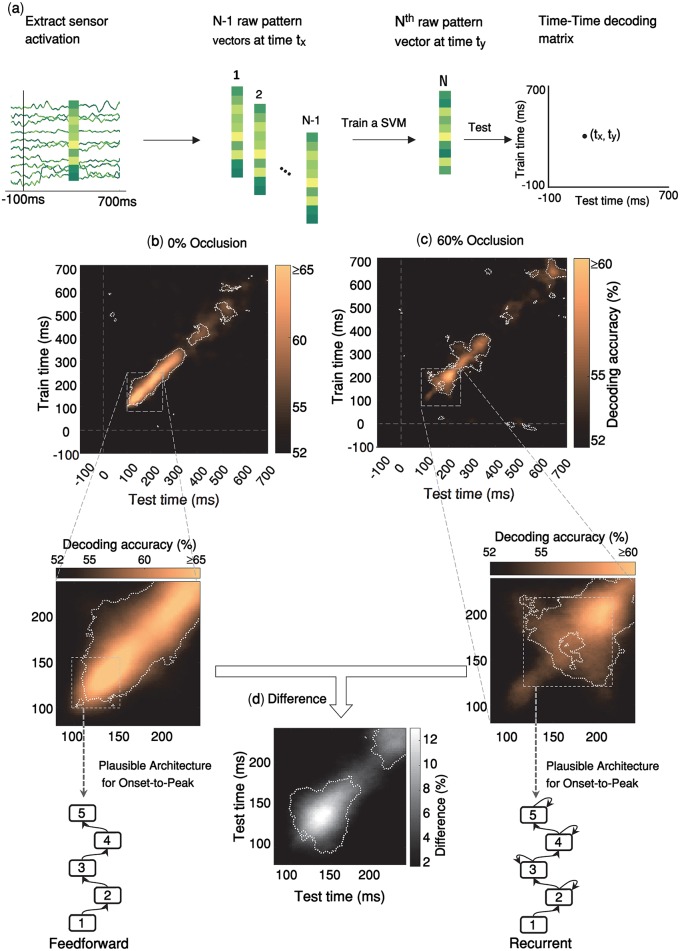
Temporal generalization patterns of object recognition with and without occlusion.(a) Time-time decoding analysis. The procedure is similar to the calculations of pairwise decoding accuracies explained in Fig 1, except that here the classifier is trained at a given time-point, and then tested at all time-points. In other words, for each pair of time points (tx, ty), a SVM classifier is trained by N-1 MEG pattern vectors at time tx and tested by the remaining one pattern vector at time ty, resulting to an 801x801 time-time decoding matrix. (b-c) Time-time decoding accuracy and plausible processing architecture for no-occlusion and 60% occlusion. The results are for MEG trials without backward masking. Horizontal axis indicates testing times and vertical axis indicates training times. Color bars represent percent of decoding accuracies (chancel level = 50%); please note that in the time-time decoding matrices, the color bar ranges for 0% occlusion and 60% occlusion are different. Within the time-time decoding matrices, significantly above chance decoding accuracies, are surrounded by the white dashed contour lines (right-sided signrank test, FDR corrected across the whole 801x801 decoding matrix, p < 0.05). For each time-time decoding matrix, we also show the plausible processing architecture corresponding to it. These are derived from the observed patterns of temporal generalization from onset-to-peak decoding (shown by the gray dashed rectangles) [see Fig 5 of [52]]. Generalization patterns for the no-occlusion condition are consistent with a hierarchical feedforward architecture; whereas, for the occluded objects (60%) the temporal generalization patterns are consistent with a hierarchical architecture with recurrent connections. (d) Difference in time-time decoding accuracies between no-occlusion and occlusion conditions. Significantly above zero differences are surrounded by the white dashed contour lines (right-sided signrank test, FDR corrected across [80–240]ms matrix at p < 0.05).